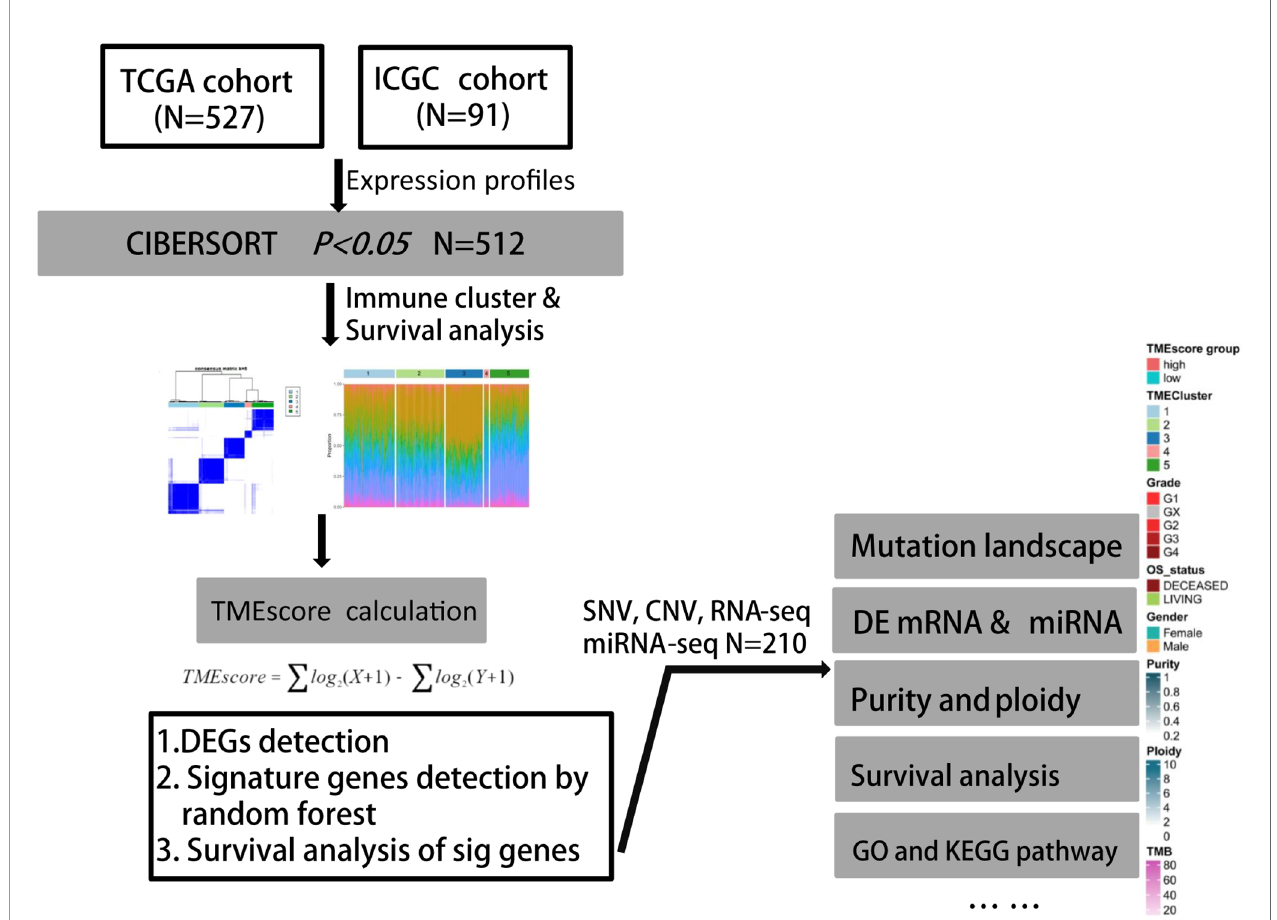
FIGURE 1 | Flowchart of analytical process of TME phenotypes and TMEscore in our study based on two independent ccRCC